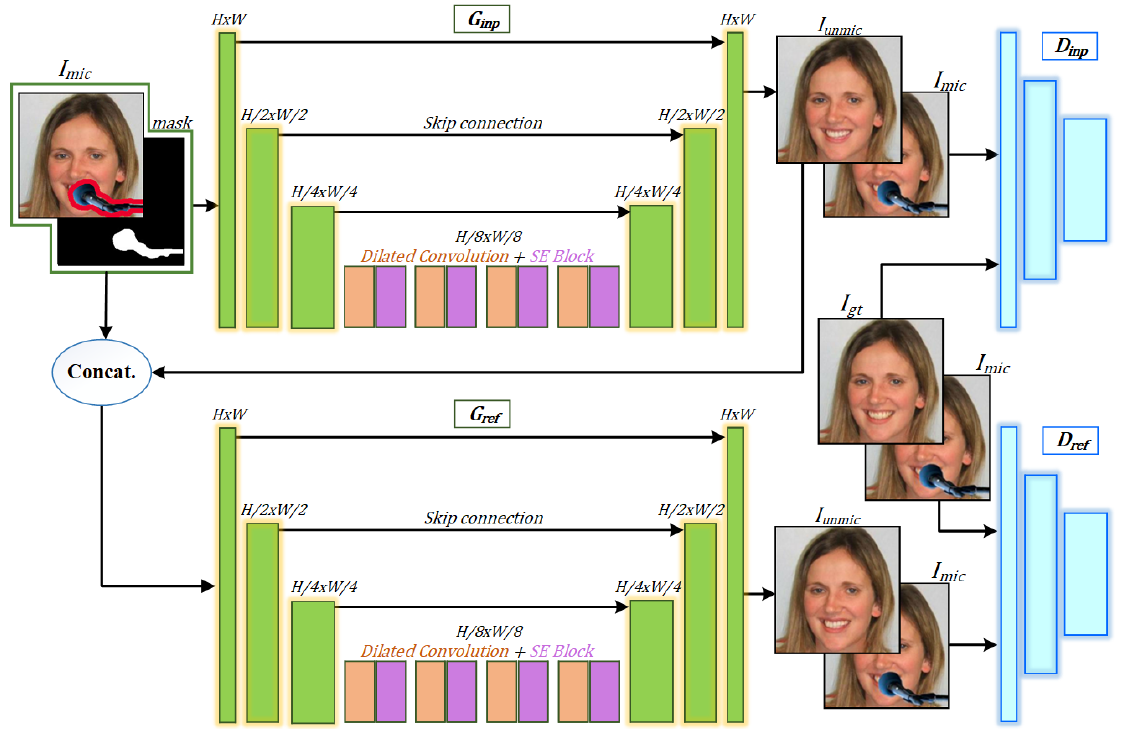
Figure 2. The proposed architecture for microphone removal: The inpainter first estimates a coarse prediction for the microphone region, followed by the refiner which produces fine details